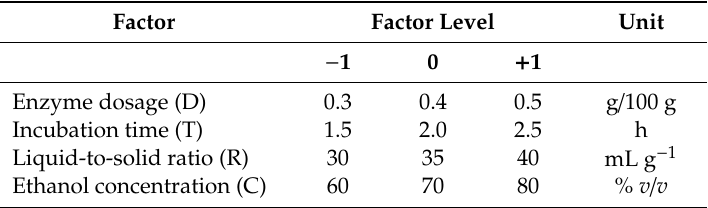
Table 1. Actual and coded levels of the factors of Box–Behnken design (BBD).